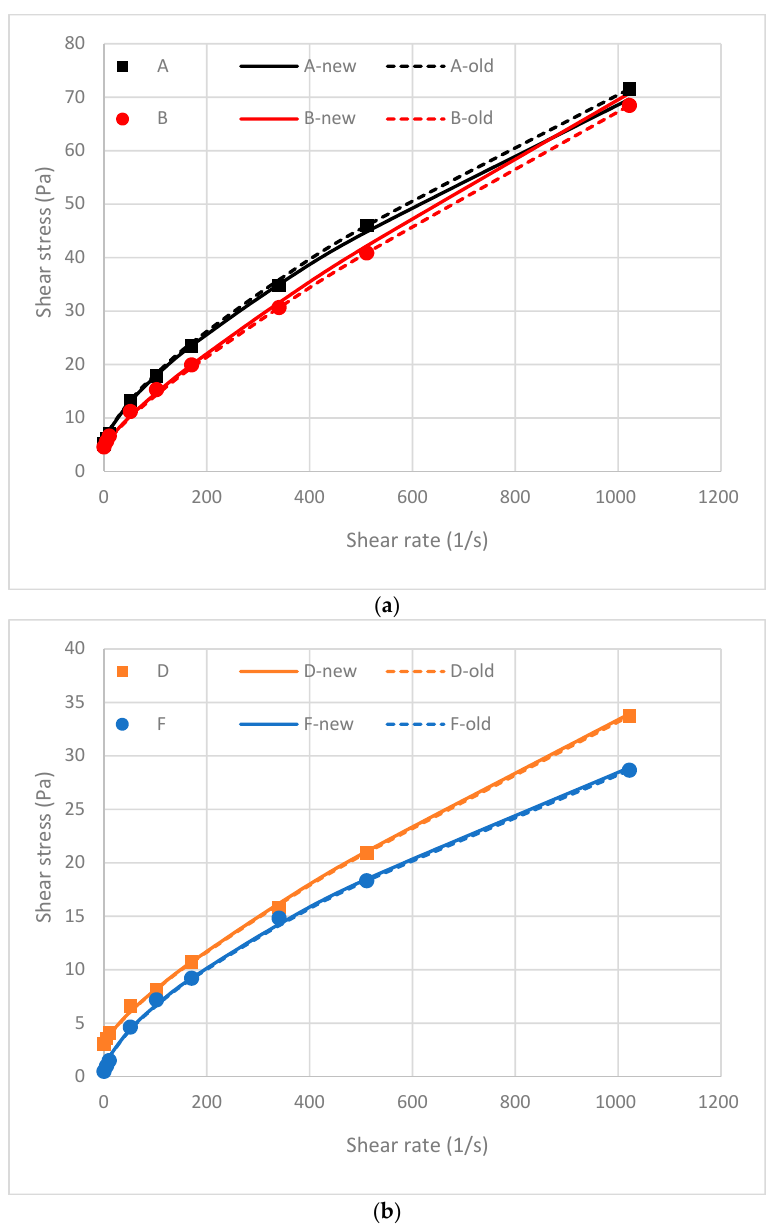
Figure 7. Flow curves of drilling fluids using the dimensionless shear rate and the shear stress at 170.3 1/s and the flow index, n , calculated from the values calculated at the shear rate of 511 and 1022 1/s. The fluids labelled “old” have also the fluid consistency factor calculated at 511 and 1022 1/s. (a) Upper figure – Fluids A and B; (b) Lower figure – Fluids D and F.